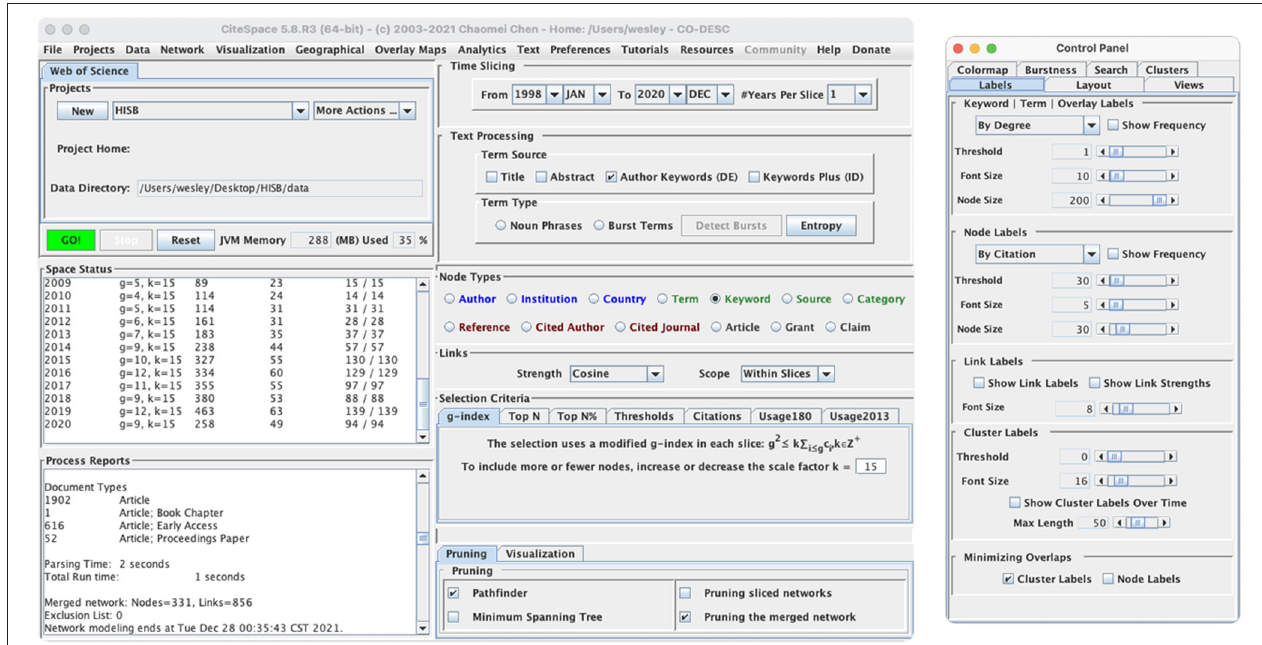
FIGURE 2 | Citespace keyword co-occurrence parameter settings.